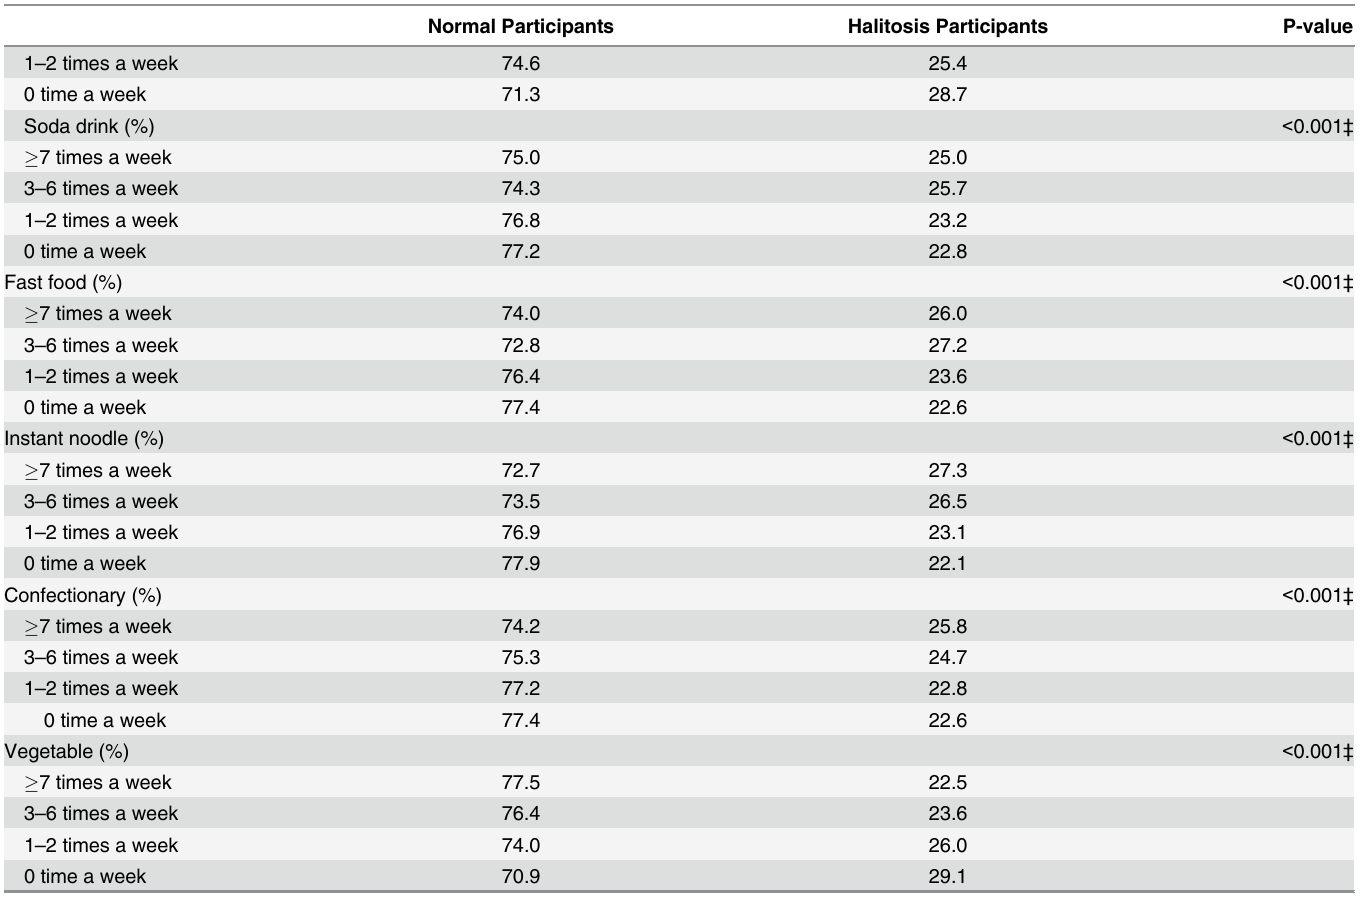
from 1.45 to 3.76 compared to ‘ very good ’ health status (95% CI = 1.42 – 1.49 and 3.31 – 4.28, respectively, P < 0.001). Compared with the no stress group, the severe stress group displayed an odds ratio of 2.94 (95% CI = 2.73 – 3.15, P < 0.001). Lower economic level was related to hal- itosis (OR = 2.47, 95% CI = 2.35 – 2.60, P < 0.001). Intake of alcohol, smoking, fast food or instant noodles more than 1 time per week and the intake of soda or confections more than 3 times per week were associated with a higher prevalence of halitosis (P < 0.001). Conversely, infrequent intake of fruits and vegetables was related to halitosis (P < 0.001). All of the analyzed variables showed significant associations with halitosis. Therefore, recip- rocally considering these covariates was prerequisite. Therefore, we performed a multiple logis- tic regression analysis with complex sampling (Table